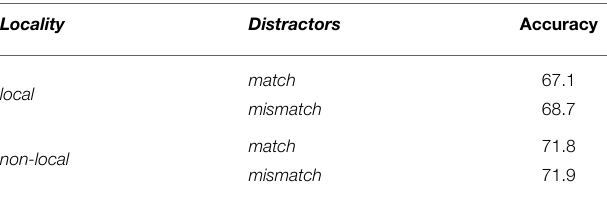
TABLE 6 | Experiment 2: Comprehension question response accuracy in percentage by experimental condition.